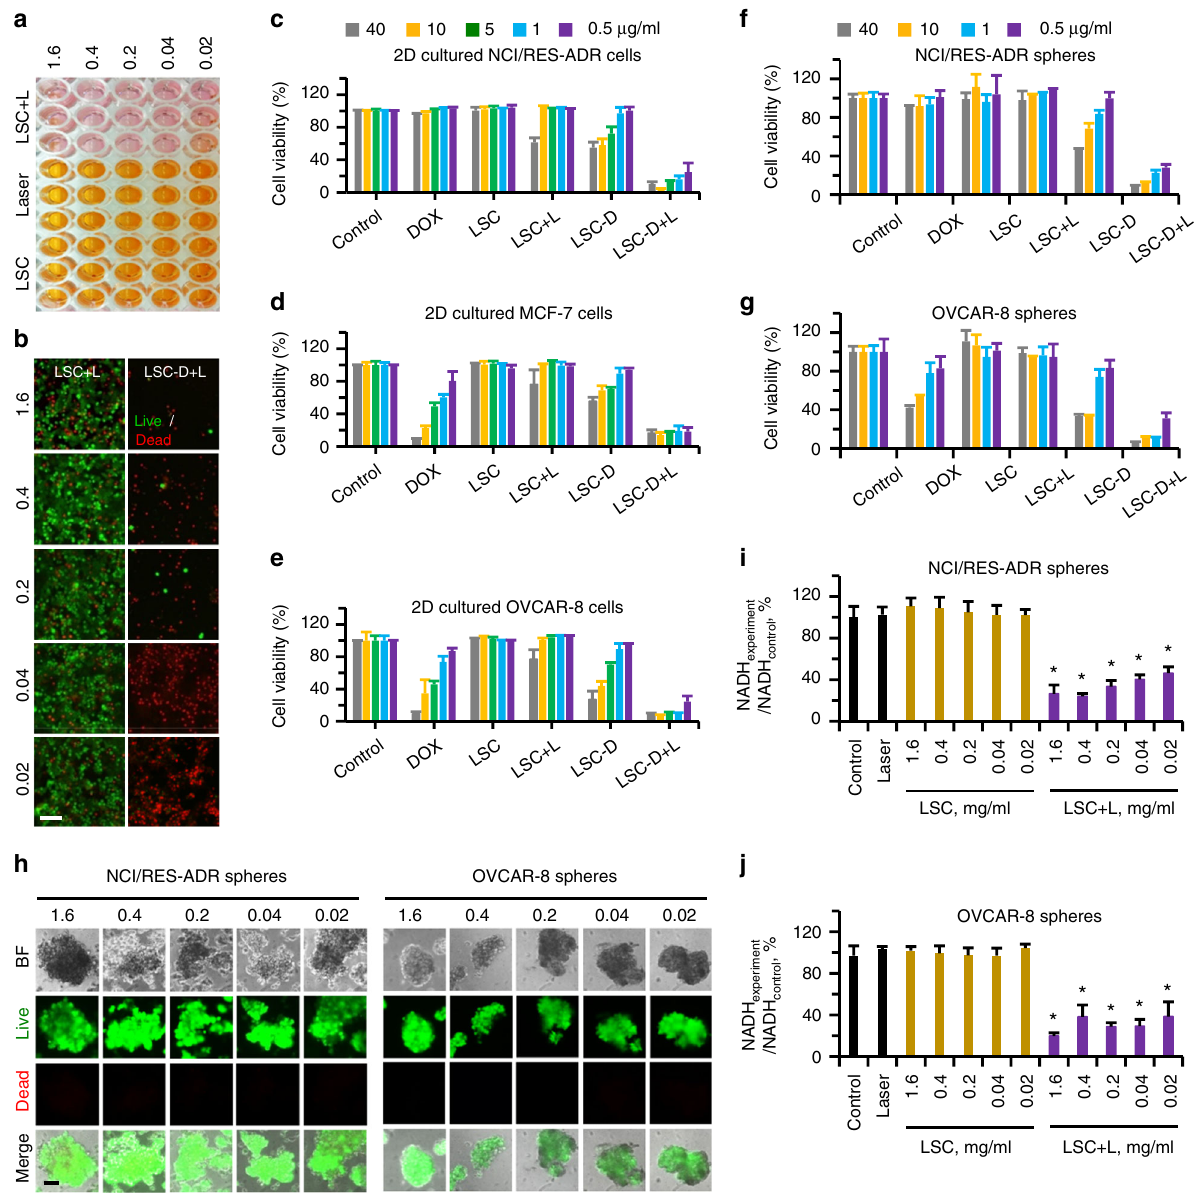
Fig. 5 Enhanced anticancer capacity of LSC-D nanoparticles under NIR laser irradiation in vitro. a Owing to the decrease of NADH by ROS oxidization in the LSC + L-treated group, the cell counting kit-8 (CCK-8) assay that relies on NADH induced color change for quanti fi cation of cell survival underestimates the cell survival for the LSC + L-treated cells. b images of live and dead stains showing that most NCI/RES-ADR cells treated with LSC + L are alive, whereas almost all the cells are dead or detached after treated with LSC-D + L. The nanoparticle concentration was 0.02-1.6 mg ml -1 . c – e Viability of NCI/RES-ADR ( c ) MCF-7 ( d ), and OVCAR-8 ( e ) cancer cells after treated with free DOX, LSC nanoparticles, and DOX-laden LSC (LSC-D) nanoparticles at different concentrations (0.02 – 1.6 mg ml − 1 empty nanoparticle and/or 0.5 – 40 µ g ml − 1 DOX) without or with NIR laser (L) irradiation (1 W cm − 2 for 1 min) quanti fi ed using crystal violet assay. Error bars represent s.d. ( n = 3). f , g Viability of NCI/RES-ADR ( f ) and OVCAR-8 ( g ) spheres enriched with CSCs after treated with free DOX together with LSC or LSC-D nanoparticles at different concentrations (0.5 – 40 µ g ml − 1 ) without or with NIR laser irradiation by using crystal violet assay. Error bars represent s.d. ( n = 3). h Images of live and dead stains showing nearly all cells are alive in spheres with the LSC + L treatment. i – j Relative NADH in NCI/RES-ADR ( i ) and OVCAR-8 ( j ) spheres showing successful inhibition NADH in LSC-treated groups with laser irradiation (LSC + L, 1 W cm − 2 , 1 min). Error bars represent s.d. ( n = 3). The LSC + L group is compared with the LSC group with the same LSC concentration, as well as the control and laser (alone) groups. * p < 0.05 (Kruskal – Wallis H -test). The fi ve nanoparticle concentrations (0.02, 0.04, 0.2, 0.4, and 1.6 mg ml − 1 ) correspond to the fi ve concentrations of DOX (0.5, 1, 5, 10, and 40 µ g ml − 1 ). Control cells were cultured in medium without any treatment. Scale bars: 100 Distribution and expression of P-gp ef fl ux pumps . We next treated cells, many of the P-gp ef fl ux pumps are distributed in the investigated the amount and distribution of the P-gp ef fl ux cytoplasm. This might be owing to the minimized ATP produc- pumps in LSC + L-treated NCI/RES-ADR cells. As shown in tion so that there is not enough energy supply to transport the P- Fig. 4a, most of the P-gp ef fl ux pumps are located on the cell gp ef fl ux pumps to the cell plasma membrane. To support this, we plasma membrane for control cells. Interestingly, for LSC + L- incubated the multidrug-resistant cells with oligomycin (an